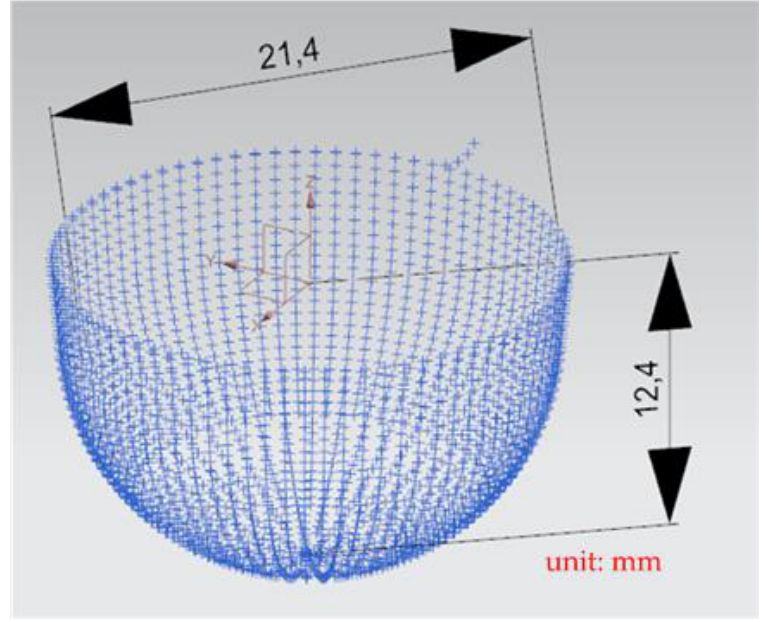
Figure 13. Spatial diagram of original concave circle roughing machining.